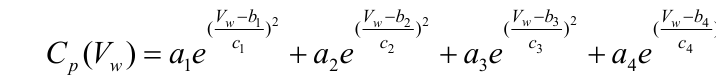
Table 1. The Gaussian Equation parameters for C